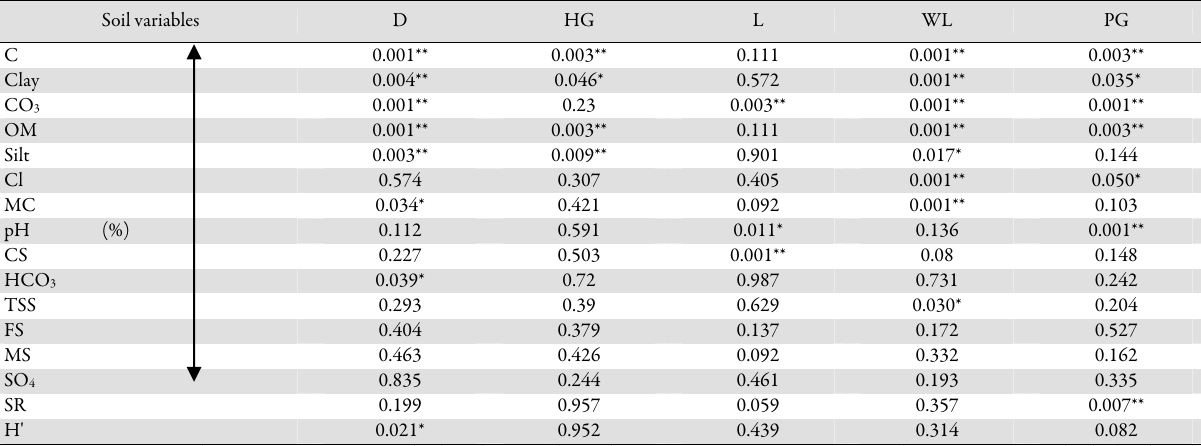
Table 3. ANOVA P values of soil variables, species richness (SR) and Shannon’s index (H’) in the stands representing the groups obtained by Twinspan in all